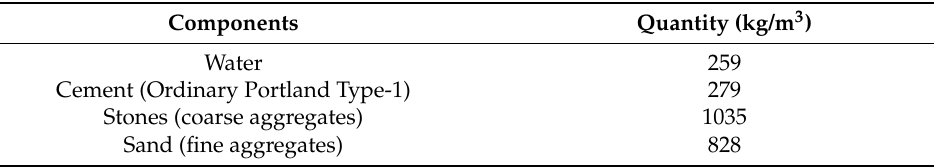
Table 2. Mix Components of Concrete.